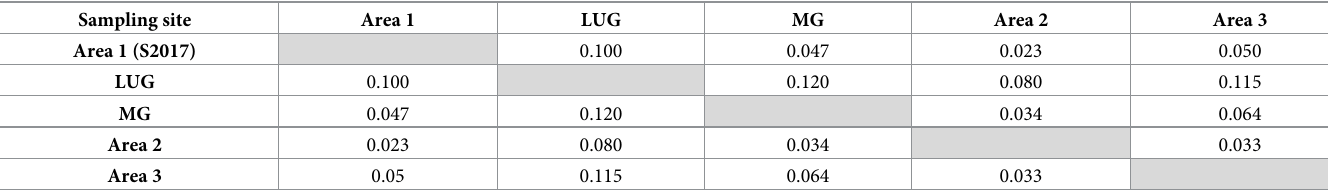
Table 3. Pairwise F ST values for Ae . aegypti collected in Buenos Aires. Sampling